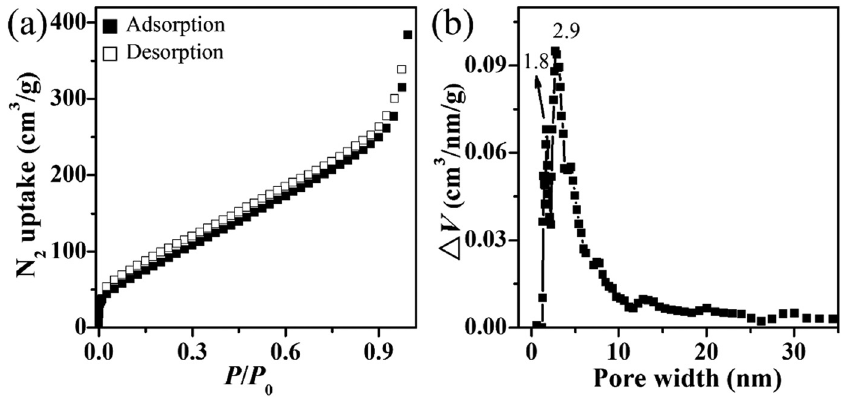
Figure 6: ( a ) Nitrogen sorption isotherms measured at 77 K and ( b ) the PSD plot fi tting by NLDFT to the sorption data of TBrTh – BTBPE – CTF.